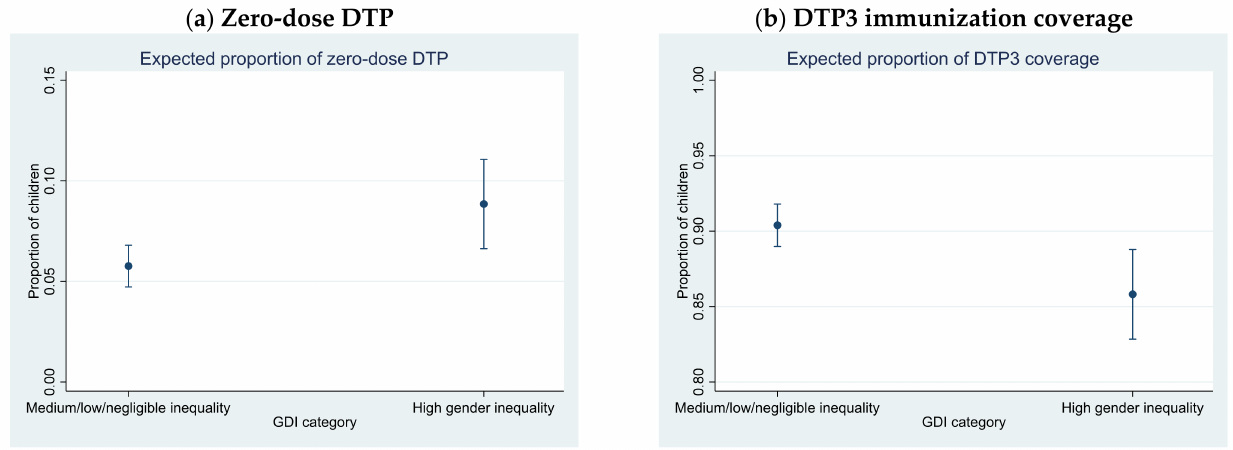
Figure 1. Adjusted proportions of ( a ) zero-dose DPT and ( b ) DTP3 immunization coverage for cate- gories of GDI, 164 countries (1 country did not have available data for this model), 2010–2019. Note: The estimated proportions are adjusted for annual population growth and age structure (measured as the percentage of the population under 15 years of age), percentage of urban population, and the three individual dimensional indices of the HDI (health index, education index, and GNI index).